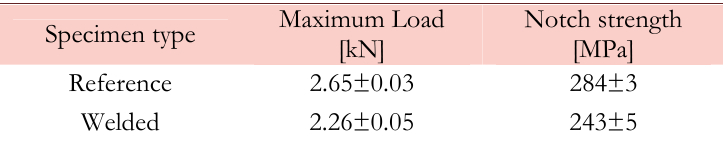
Table 1: Mechanical strength of the SEC specimens